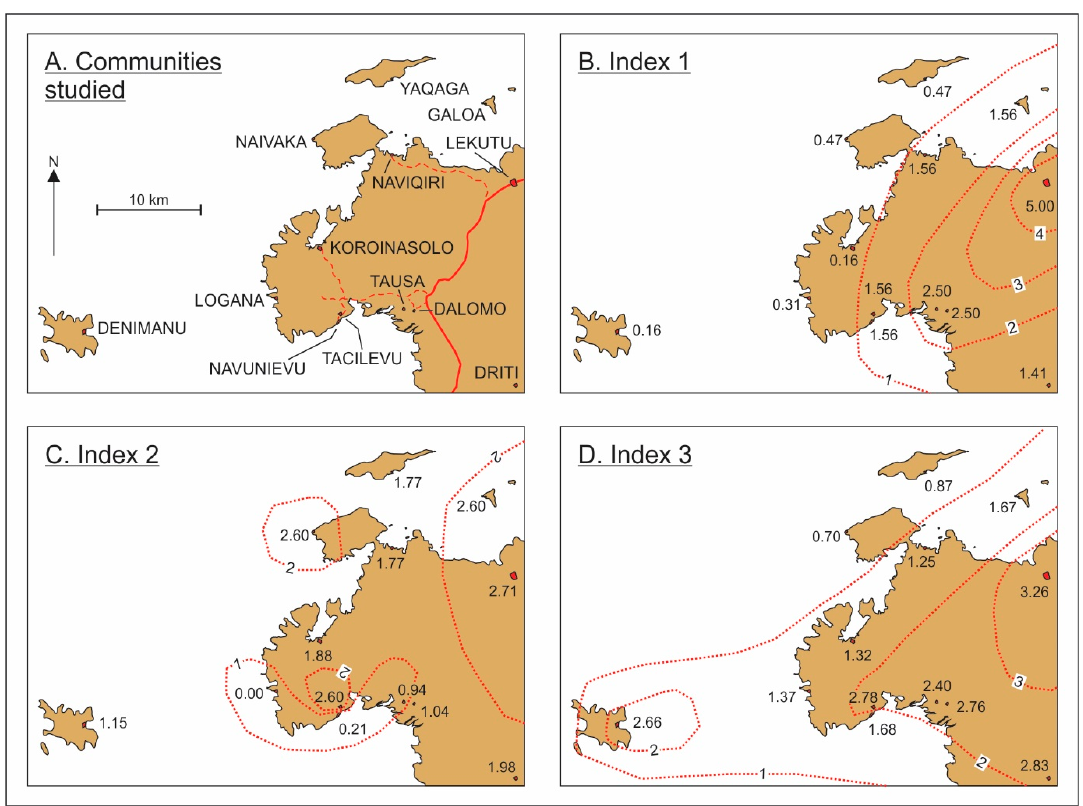
Figure 3. Maps of Indices 1–3 in Bua.